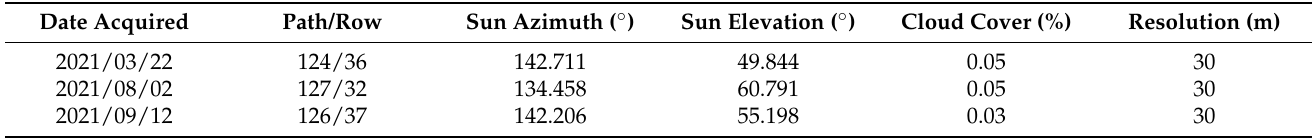
Table 2. Image data were utilized to classify the research area.